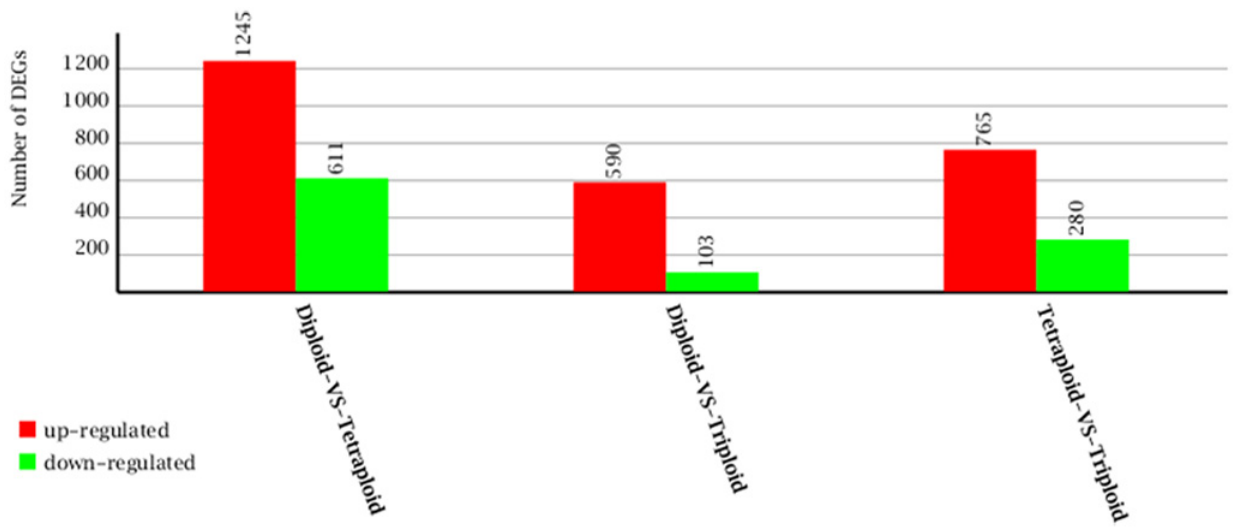
Fig 6. Analysis of differently expressed genes via pairwise contrasts of different ploidy with | log2Ratio | (cid:2) 1.0 and FDR (cid:3) 0.001.